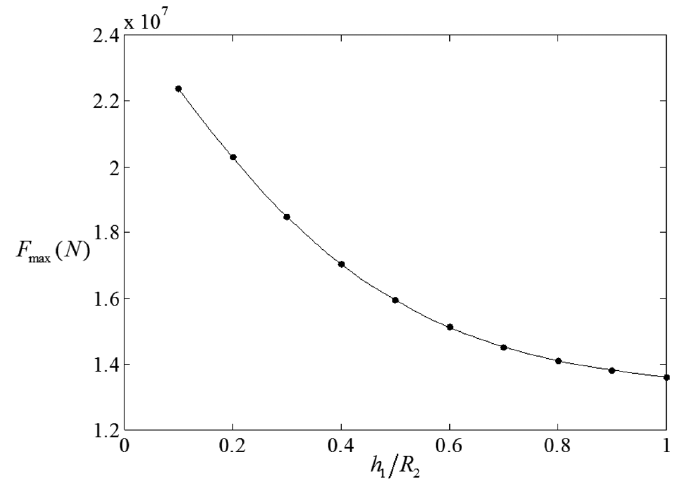
Fig. 15. Maximum amplitude in the time history of the resultant hydrodynamic force under the Kobe seismic excitation versus h 1 / R 2 for R 1 / R 2 = 0.4.